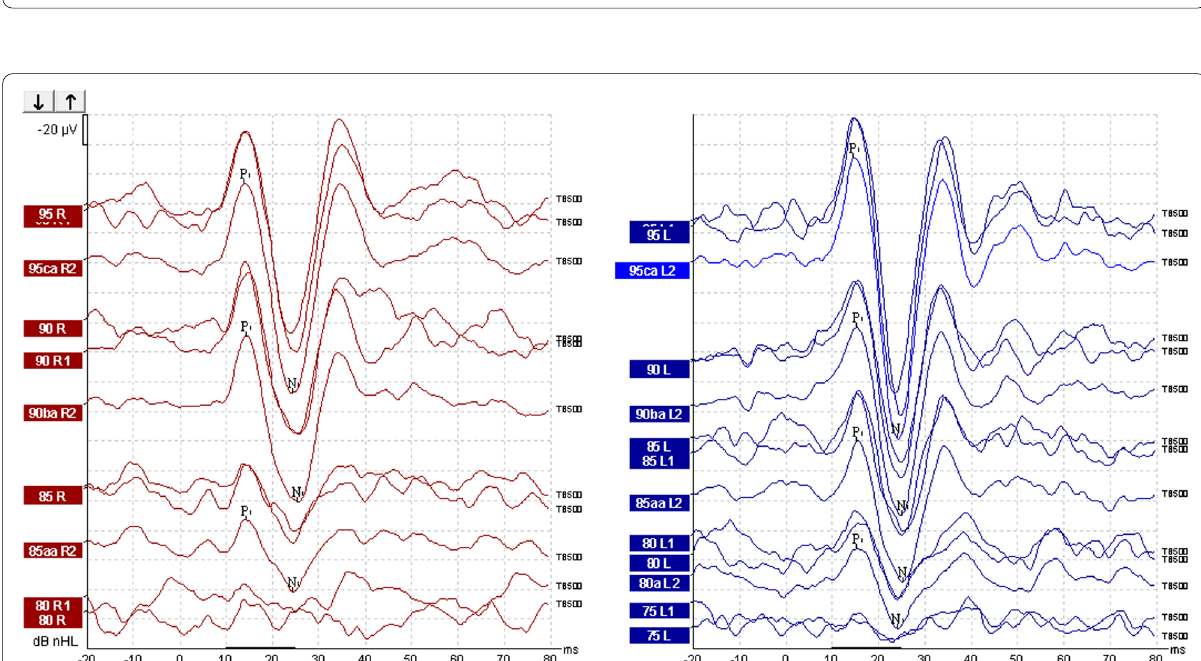
Fig. 2 Bone conducted cVEMPs responses were obtained from the same male individual. (BC cVEMPs responses, right and left ear VEMPs threshold 40 dB nHL)